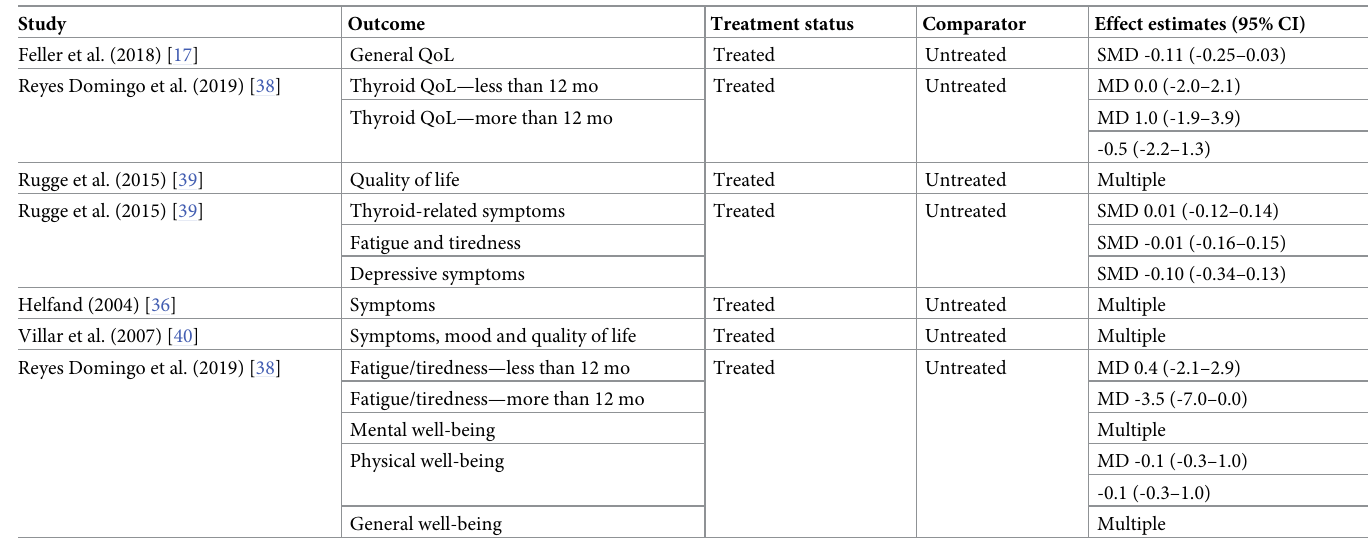
Table 8. Primary review findings on quality of life and symptoms.